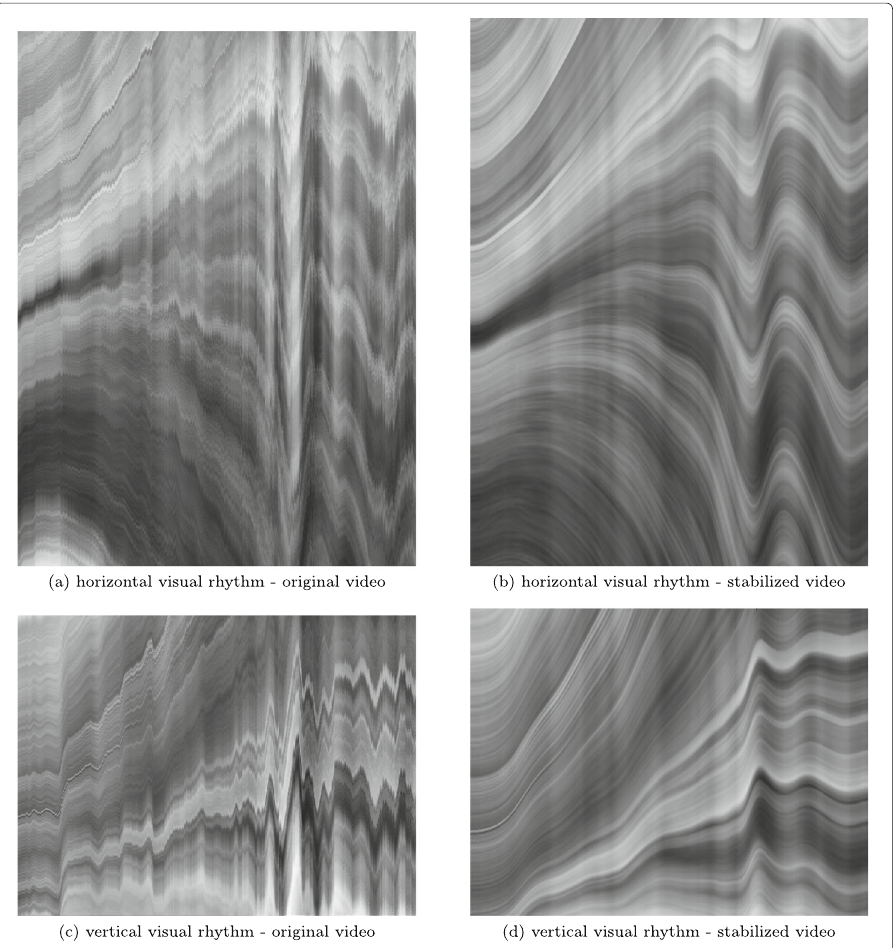
Fig. 15 Visual rhythms for video Zooming 0 . a Horizontal visual rhythm for original video. b Horizontal visual rhythm for stabilized video. c Vertical visual rhythm for original video. d Vertical visual rhythm for stabilized